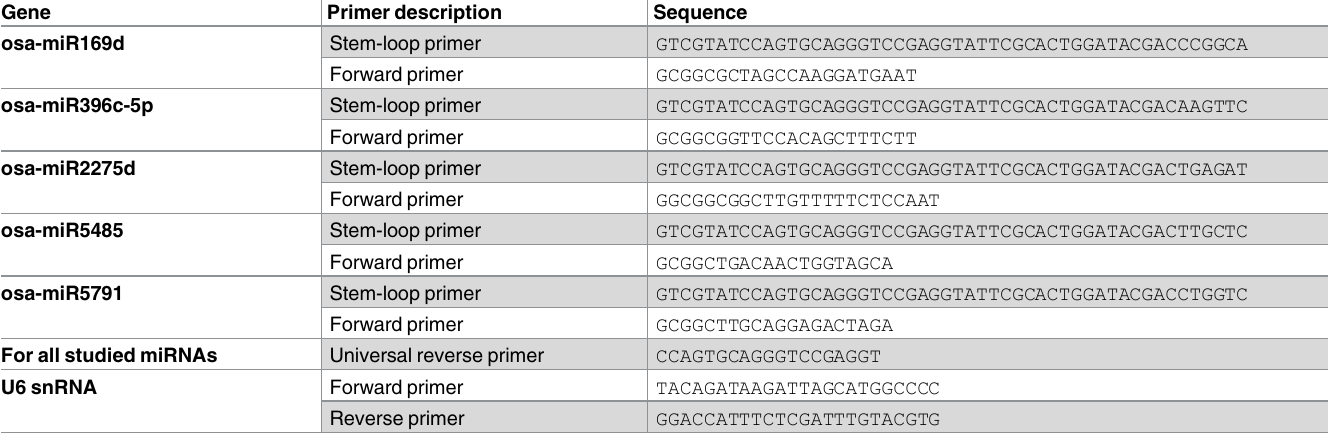
Table 1. List of the primers used in quantitative stem-loop RT-PCR for shortlisted drought-responsive miRNAs in the inflorescence tissues of IR64, IR87705-7-15-B and